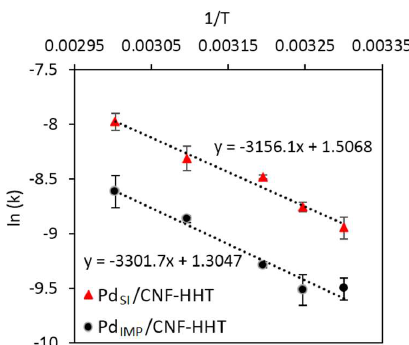
Figure 8. Arrhenius plot of 1 wt. % Pd/CNF prepared by sol-immobilisation and impregnation from 30 to 60 °C. Reaction conditions: 26.5 mg of catalyst (Substrate/metal molar ratio: 2000:1), 0.5 M HCOOH, 750 rpm, and 2 h reaction time.